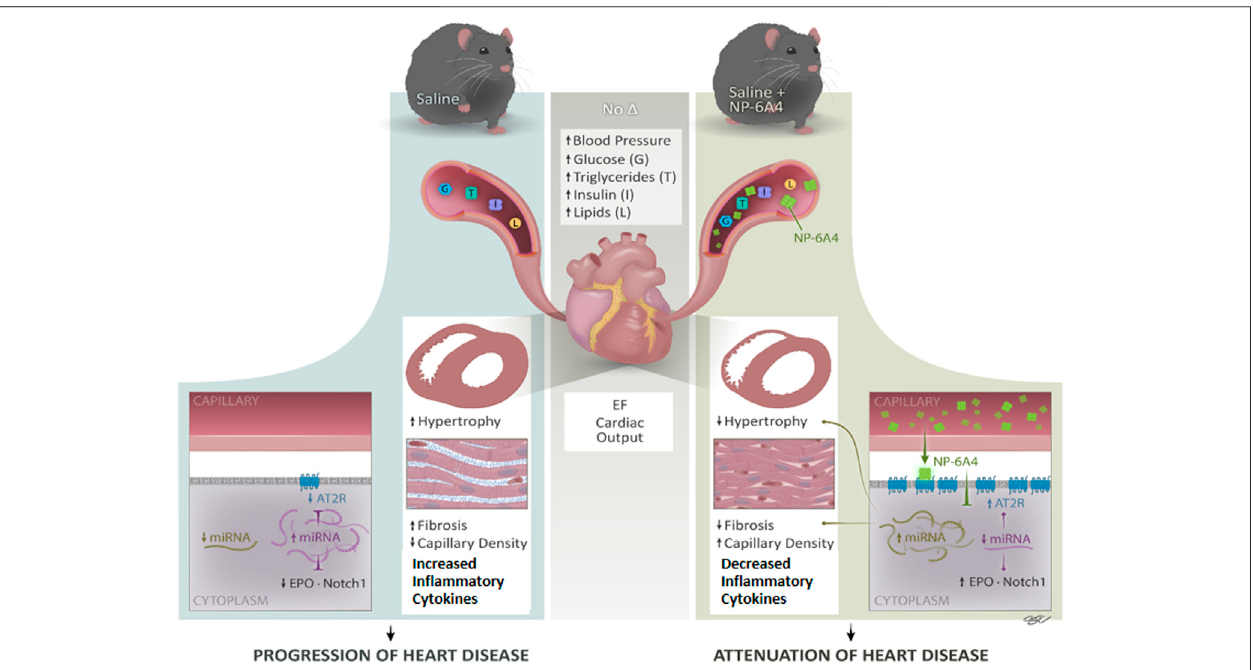
FIGURE 7 | NP-6A4 mitigates heart disease via a new multi-prong signaling that coordinates expression of cardioprotective protein and miRNA in conditions of untreatedobesityandpre-diabetes.CartoondiagramsummarizesthekeyeventsunderlyingcardioprotectioninducedbyNP-6A4-AT2Rsignalinginuntreated diabetes and obesity. NP-6A4 treatment attenuated cardiac dysfunction as evidenced by reduced E/e ’ , improved GLS and GCS. NP-6A4 suppressed myocardial structural damage as evidenced by reduction in fi brosis, cardiomyocyte hypertrophy, and loss of microvascular density. These protective effects were mediated by a coordinated increase in the expression of cardio-reparative AT2R, EPO and Notch1 (marked in the diagram) and suppression of nineteen pro-in fl ammatory and/or pro- fi brotic cytokines. Expression of multiple miRNAs that can potentially target AT2R, EPO and Notch1 (shown in purple) are suppressed whereas miRNAs implicated in attenuating heart failure, hypertrophy and fi brosis and suppressing in fl ammatory cytokines (shown in light green) are increased by NP-6A4-AT2R signaling. Since all these cardioprotective effects are induced in conditions of untreated obesity, and without modulating blood pressure, NP-6A4 can be an exciting synergistic drug for anti-hyperglycemic, anti-lipidemic and anti-hypertensive drugs to mitigate severe cardiac in fl ammation and heart disease.